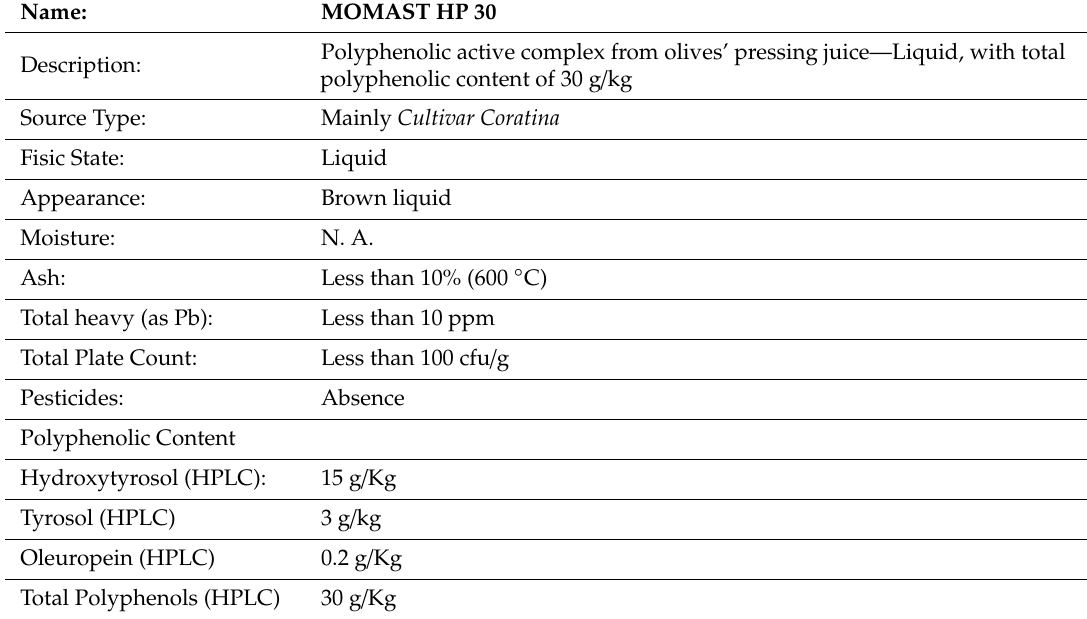
Table 2. Characteristics of the Polyphenolic Complex MOMAST ( ® ) HP